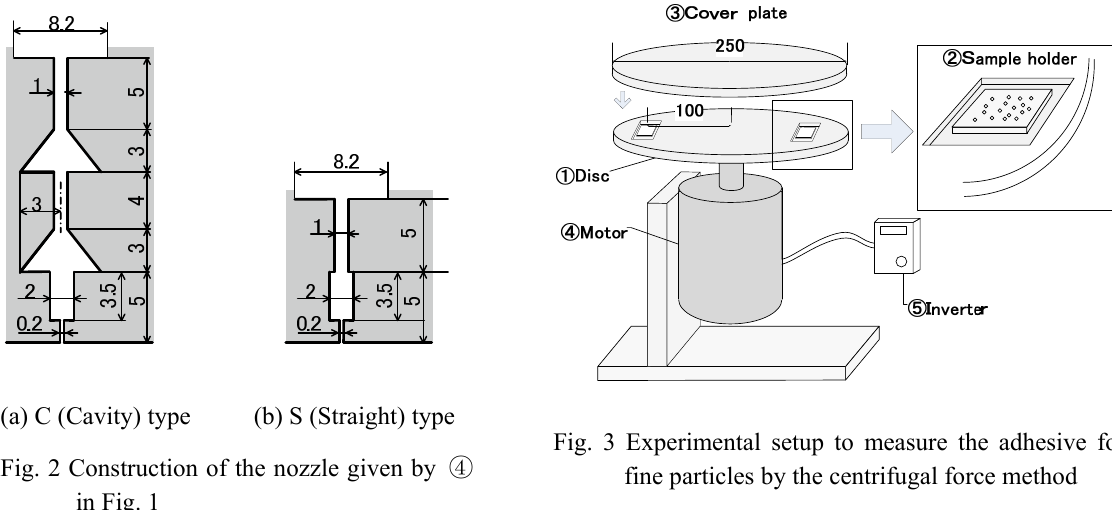
Fig. 2 Construction of the nozzle given by ④ in Fig. 1